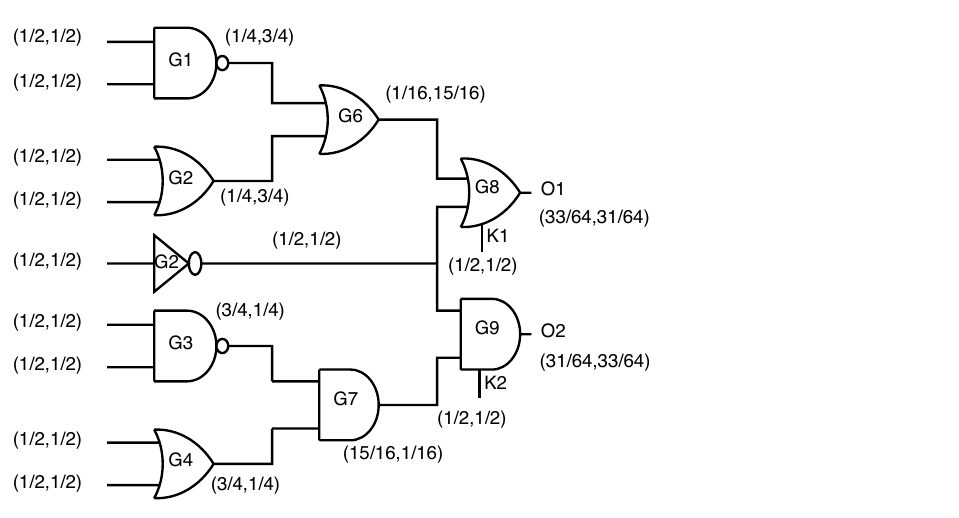
Figure 24. Output probability analysis using key-based